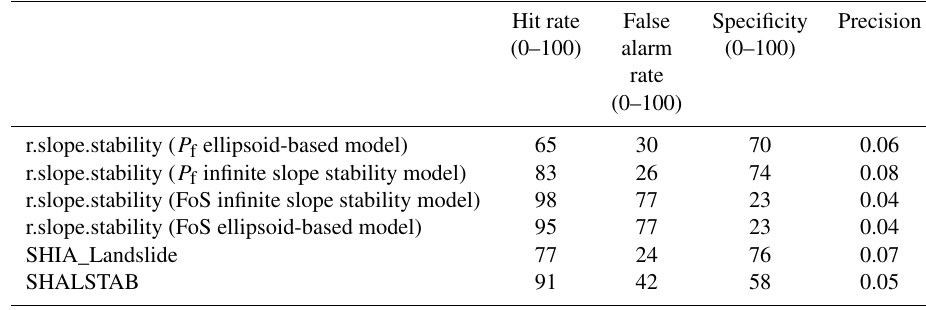
Table 4. Statistical indexes measuring the performance of r.slope.stability and the other